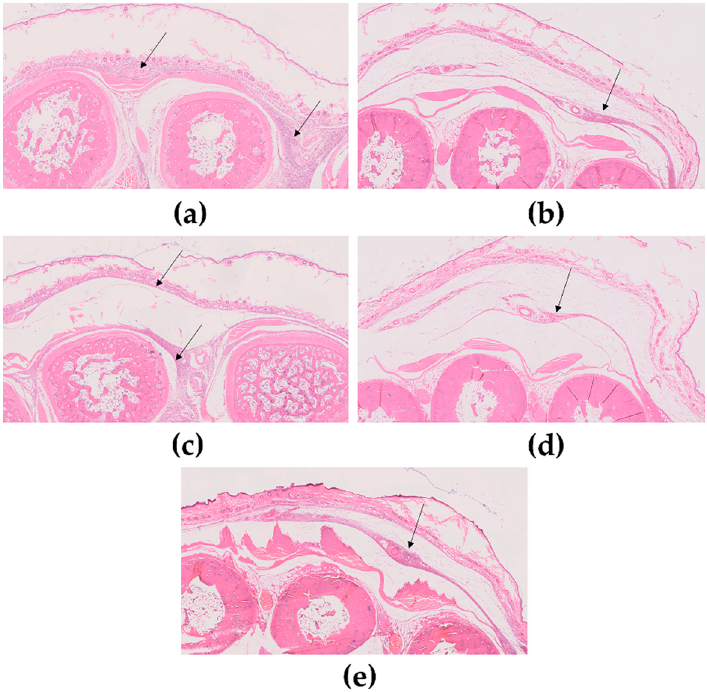
Figure 14. Representative histological images of rat’s paws (2.5 × , H&E) after topical administration. ( a ) Negative Control; ( b ) Positive Control; ( c ) Free extract; ( d ) Extract-loaded PLGA NPs; ( e ) Extract-loaded PCL NPs. Arrows show the inflammation area.